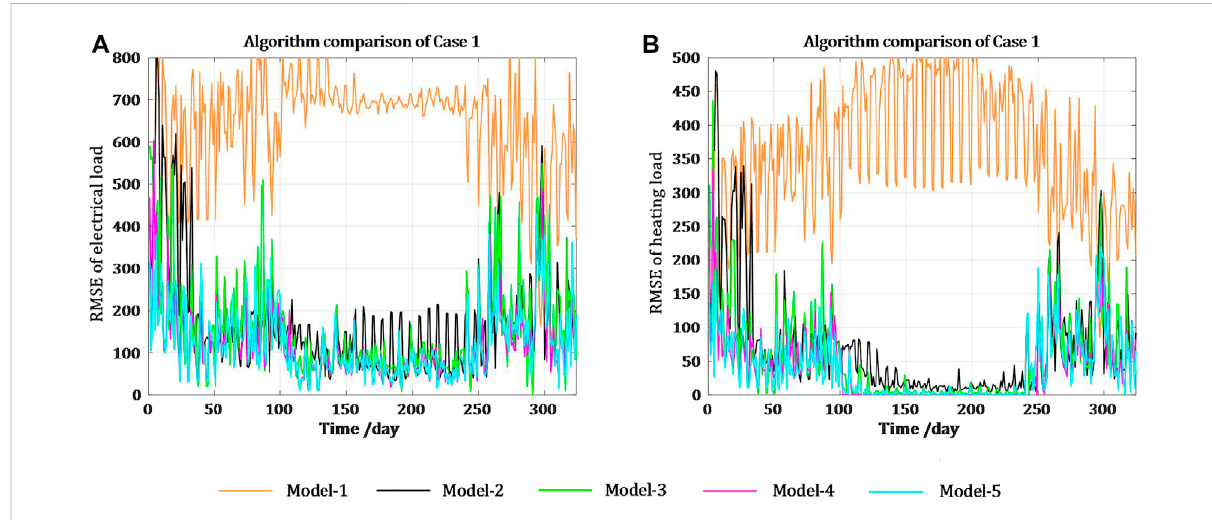
FIGURE 11 Comparison of distribution of RMSE for the different models in Case 1.